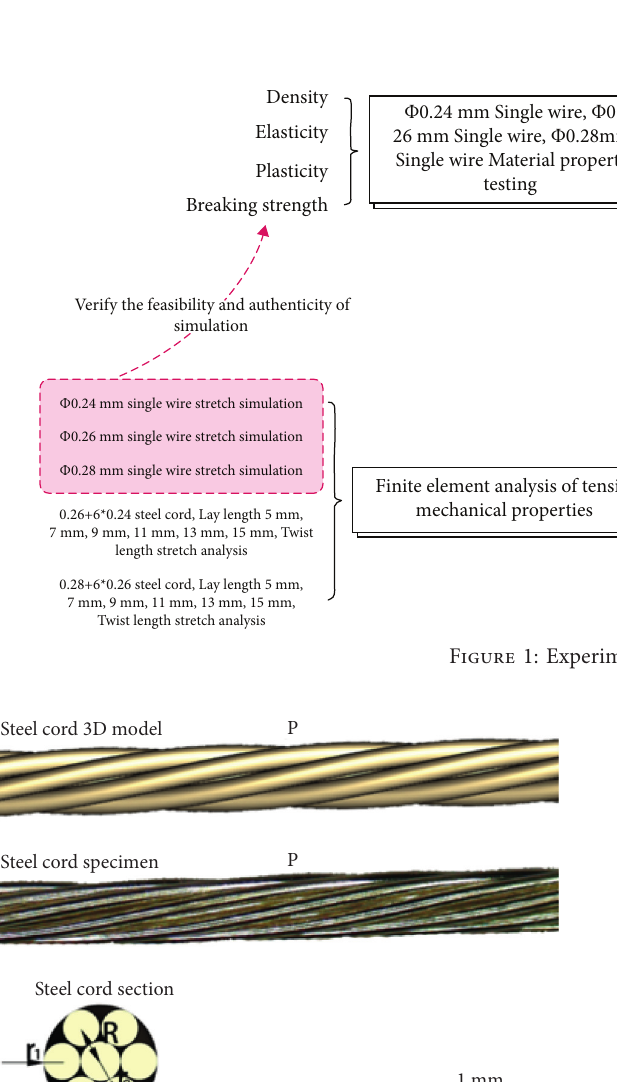
Figure 2: Steel cord model and specimen parameters.